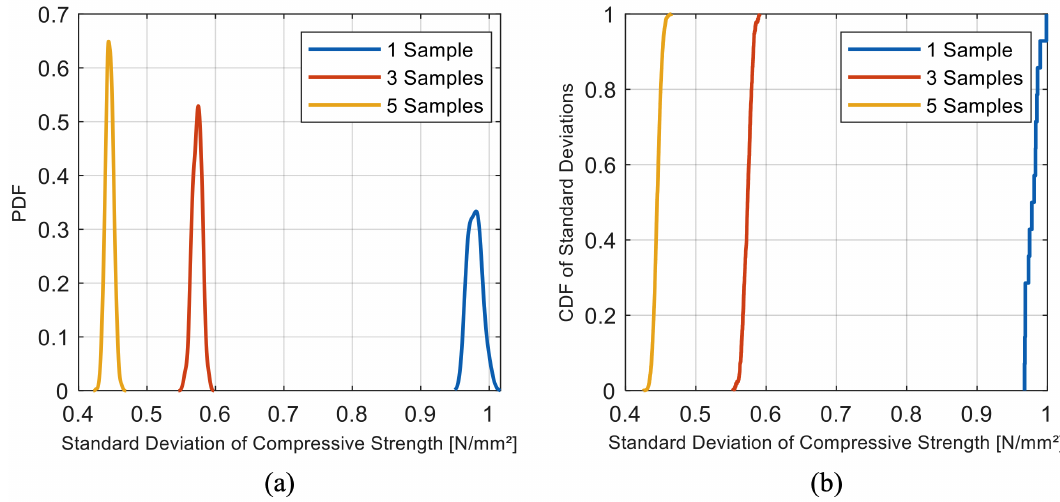
Figure 7. (a) Kernel density function and (b) eCDF of the simulation results of the standard deviation using 1, 3 and 5 drill